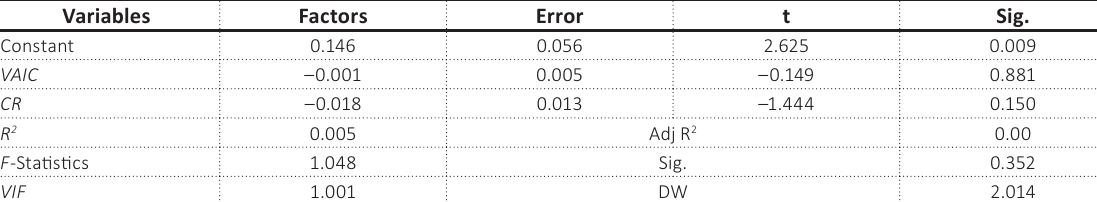
Table 6. The first model (companies with positive profits)